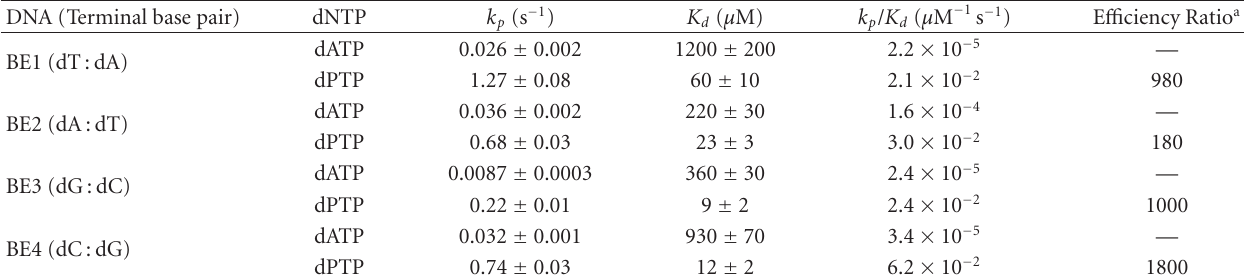
Table 4: Kinetic parameters for nucleotide incorporation onto blunt-end DNA catalyzed by truncated yeast Pol η at 23 ◦ C. DNA (Terminal base pair)